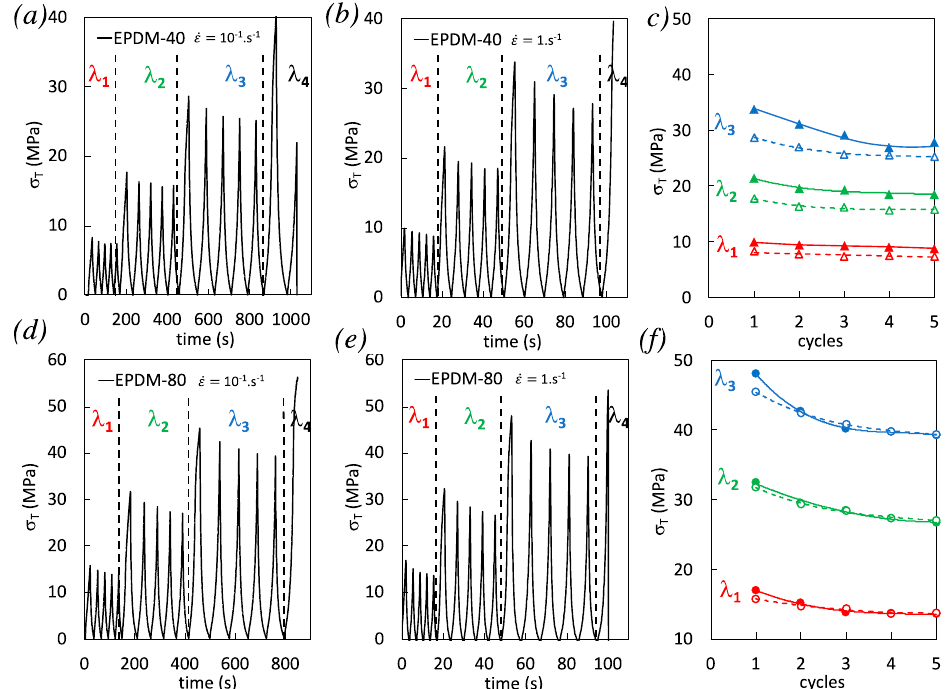
Figure 5. ( a – b ) True stress at the strain rates 10 − 1 s − 1 and 1 s − 1 for EPDM-40. ( c ) Corresponding maximum stress reached during multiple cyclic loadings performed at three different stretching ratios λ 1 = 2 (in red), 2 = 2.9 (in green), and 3 = 3.7 (in blue), and for the strain rates 10 ⁻ 1 s ⁻ 1 (unfilled symbols) and 1 s − 1 (filled symbols). ( d – e ) True stress at the strain rates 10 − 1 s − 1 and 1 s − 1 for EPDM-80. ( f ) Corresponding maximum stress reached during multiple cyclic loadings performed at three different stretching ratios λ 1 = 2 (in red), λ 2 = 2.9 (in green), and λ 3 = 3.7 (in blue), and for the strain rates 10 − 1 s − 1 (unfilled symbols) and 1 s − 1 (filled